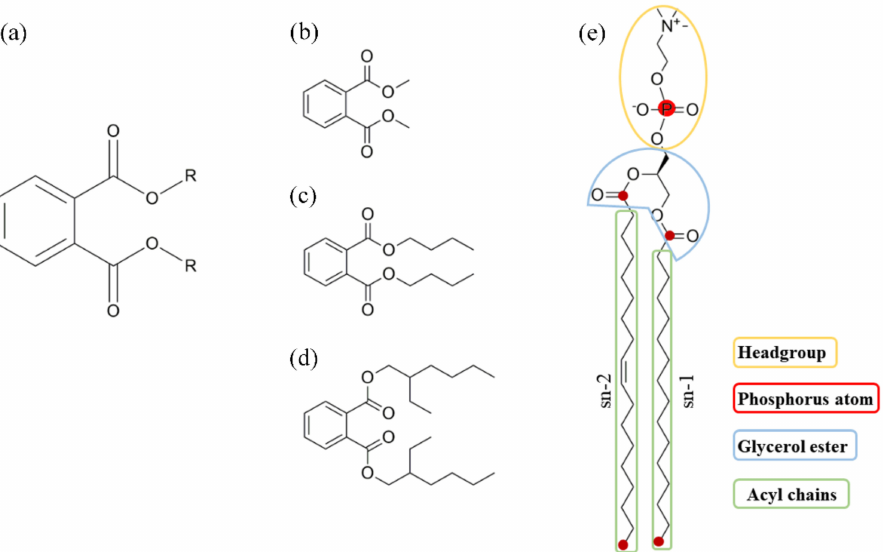
Figure 1. Chemical structures of molecules in this study: ( a ) general structure of phthalic acid esters (PAEs); ( b ) dimethyl phthalate (DMP); ( c ) dibutyl phthalate (DBP); ( d ) di-2-ethyl hexyl phthalate (DEHP); ( e ) 1-Palmitoyl-2-oleoyl-sn-glycero-3-phosphorylcholine